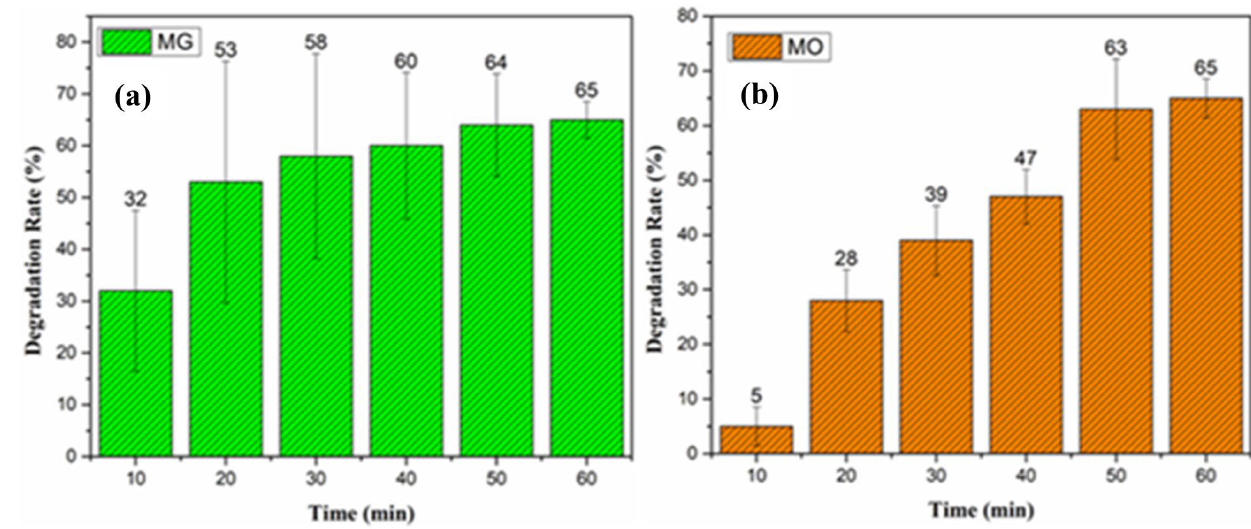
Figure 8. Degradation rate of ( a ) MG and ( b ) MO dyes. Table 1. Degradation rates (%) and rate constants for photocatalytic degradation of dyes using bio- genic CuO NPs.